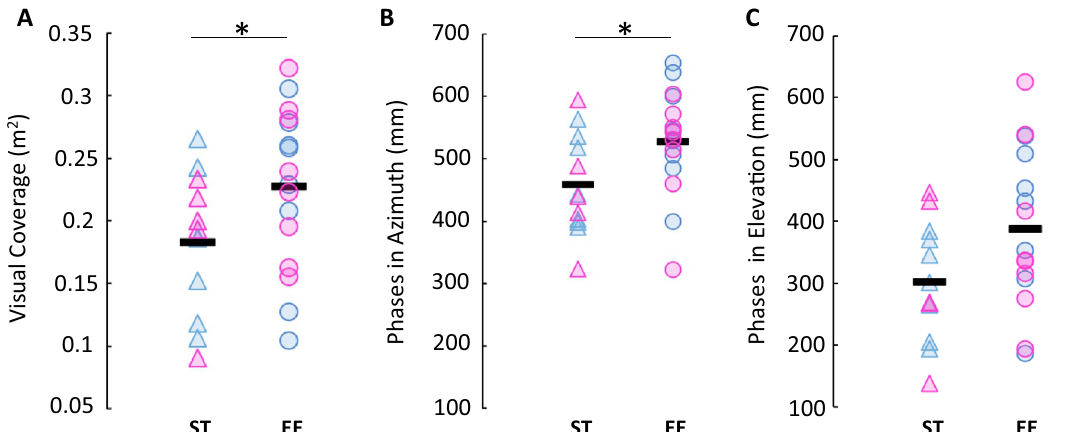
Figure 3. Mice reared in an enriched environment had a greater span of visual field coverage. ( A ) Total visual field coverage by group, p = 0.0311 (one-tailed Welch’s t-test). *p < 0.05. ( B ) Visual span in azimuth by group, p = 0.0193 (one-tailed Welch’s t-test). *p < 0.025. ( C ) Visual span in elevation by group, p = 0.0292 (one-tailed Welch’s t-test). Individual data points represent individual animals. Pink triangle: ST female (n = 5); blue triangle: ST male (n = 7); pink circle: EE female (n = 8); blue circle: EE male (n = 8). Black line represents the